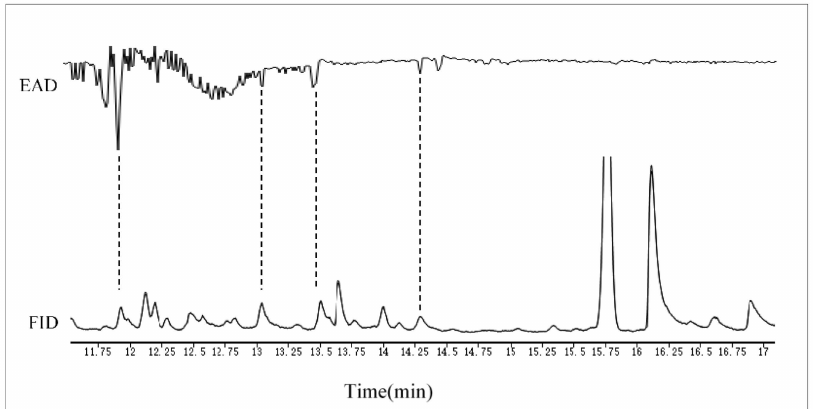
Figure 5. Coupled GC-EAD analysis showing antennal responses of female Aphidius gifuensis to volatile organic compound samples collected from wheat plants that were treated with MeSA (1 mmol/L). Upper trace: antennal response, lower trace: FID response. The EAD-active VOCs for female A. gifuensis were identified as: m-Diethyl-benzene, p-Cymene, Carveol and